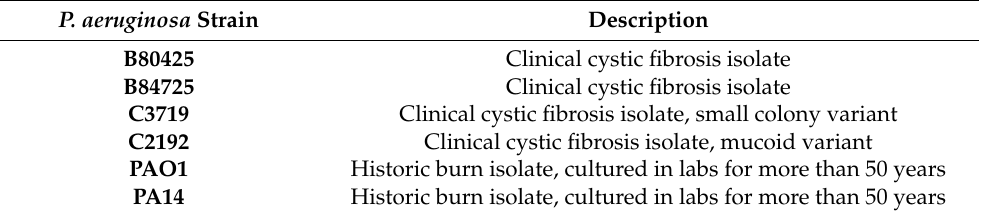
Table 4. P. aeruginosa strain